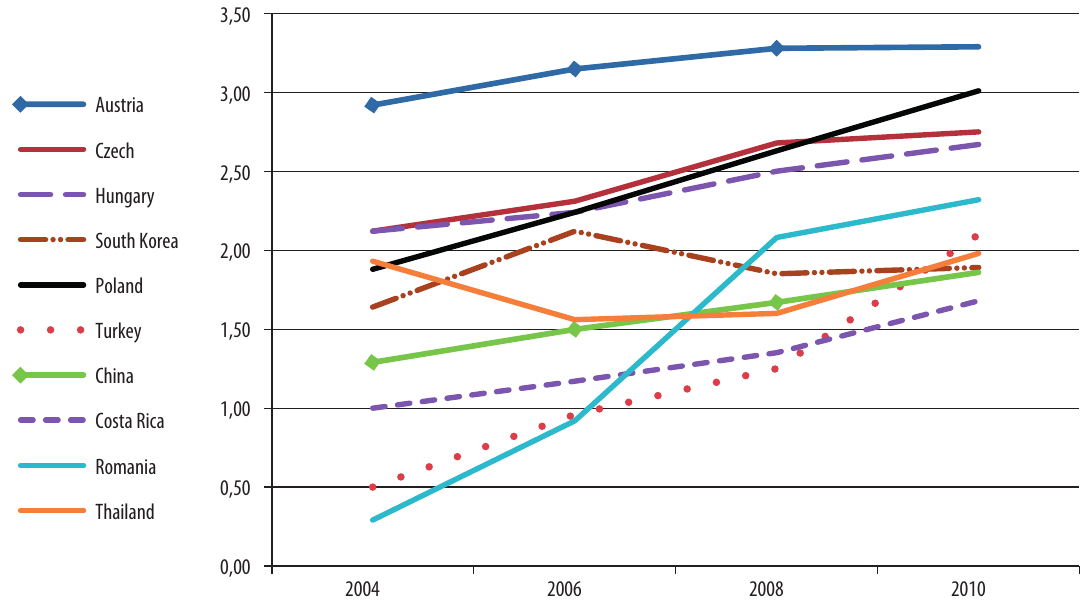
Fig. 1. Real estate transparency scores in some of the countries under study (JLL 2004, 2006, 2008,